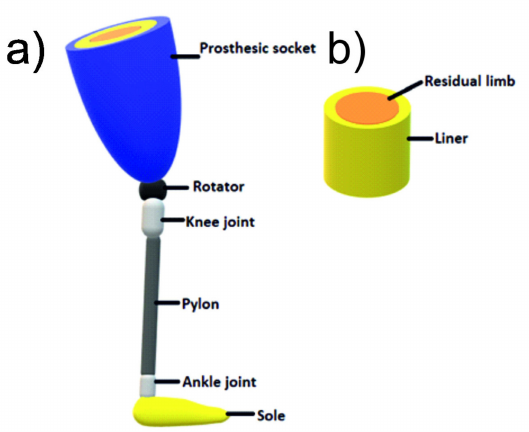
Figure 1. Simplified prosthesis structure: structure ( a ) and stump with liner ( b )